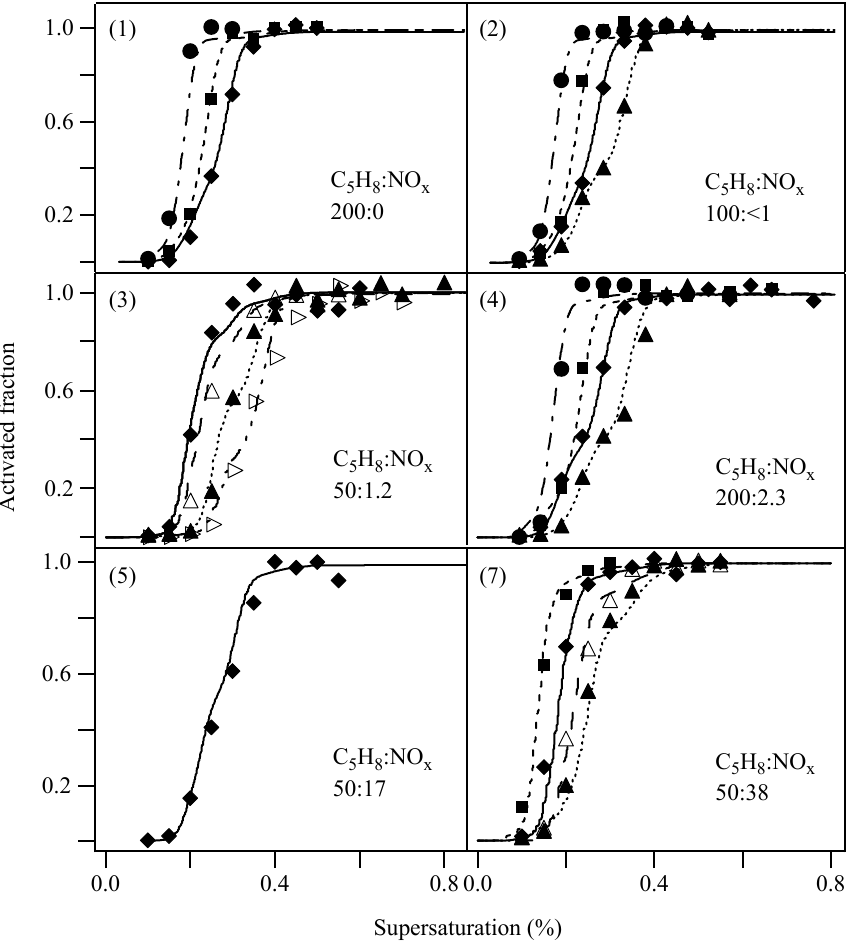
Fig. 3. Observed and modeled CCN activation curves for the experiments described in Table 1 at a thermodenuder setting of 25 ◦ C. In each panel, the initial isoprene concentration (ppbv) prior to reaction and the steady-state NO x concentration (ppbv) during reaction are indicated as ratios. The particle mode diameters selected by DMA 2 for measurement of their activation curves include 70nm ( B ; dashed double-dotted line), 80nm ( N ; dotted line), 90nm ( 4 ; long-dashed line), 100nm ( (cid:7) ; solid line), 120nm ( (cid:4) ; short-dashed line), and 150nm ( dotted line). The shown data points represent averages across several